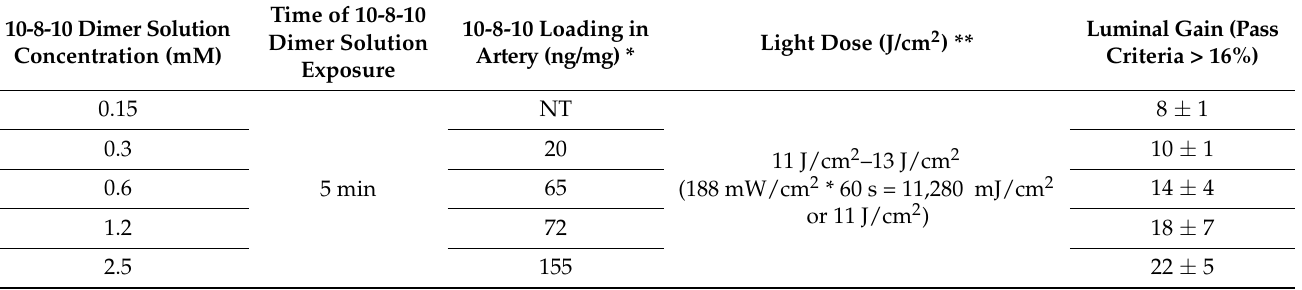
Table 1. Luminal gain measurements using in vitro porcine carotid